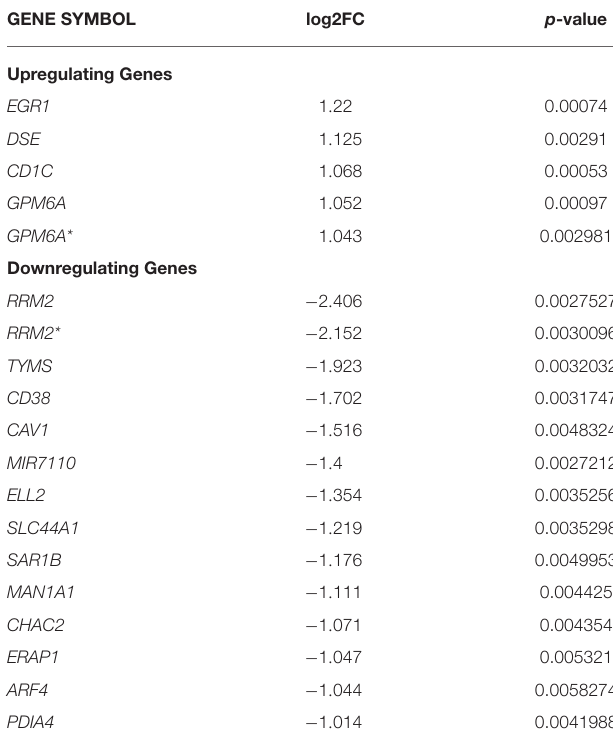
*The asterisk denotes the DEGs with two different probes from the